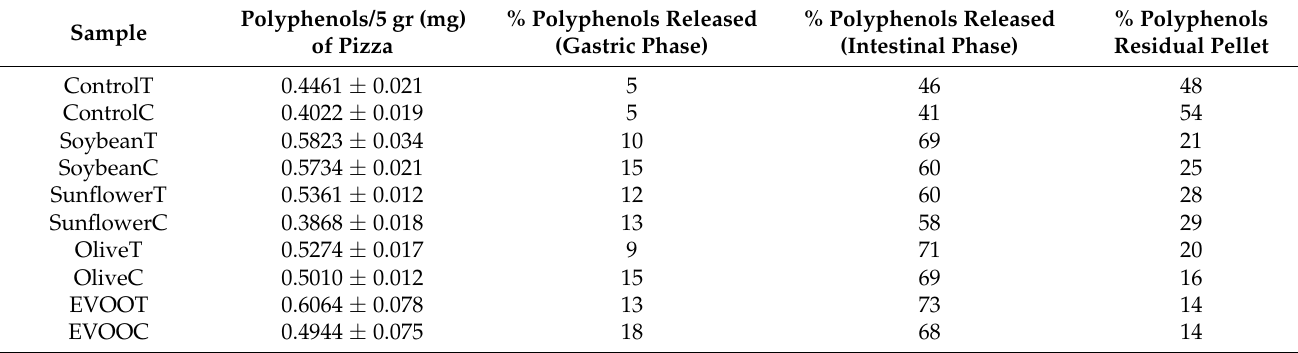
Table 1. Bioaccessibility of polyphenols in the “marinara” pizzas expressed as percentage released at the gastric and intestinal